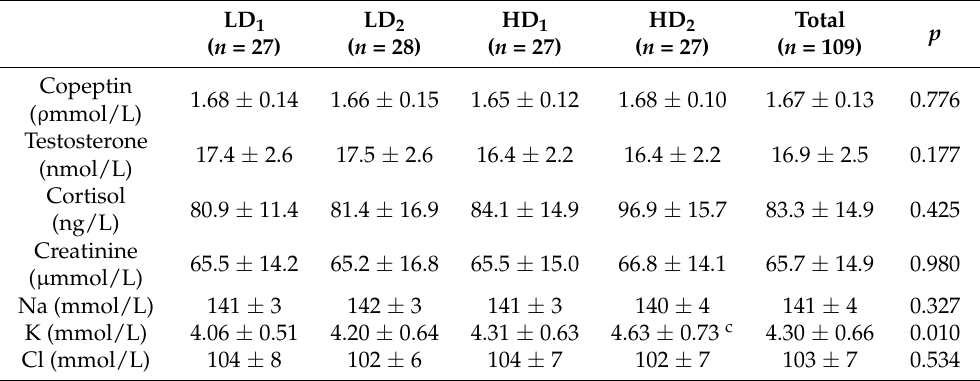
Table 4. The characteristics of blood samples among participants consuming different levels of total drinking